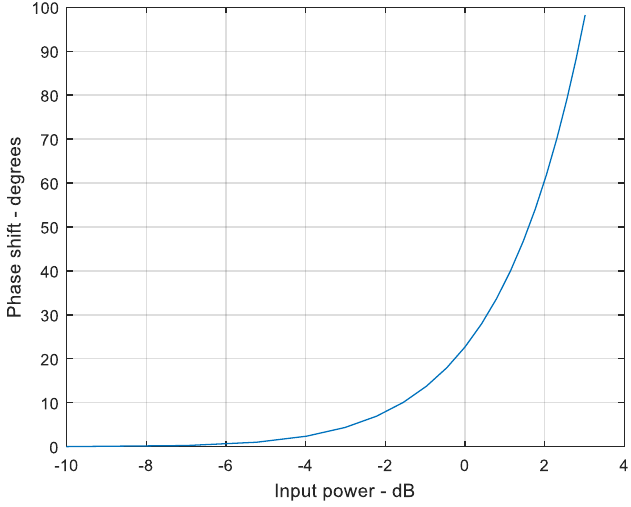
Figure 5. AM / PM characteristic curve of the Saleh Figure 5. AM/PM characteristic curve of the Saleh model. Figure 5. AM/PM characteristic curve of the Saleh model.